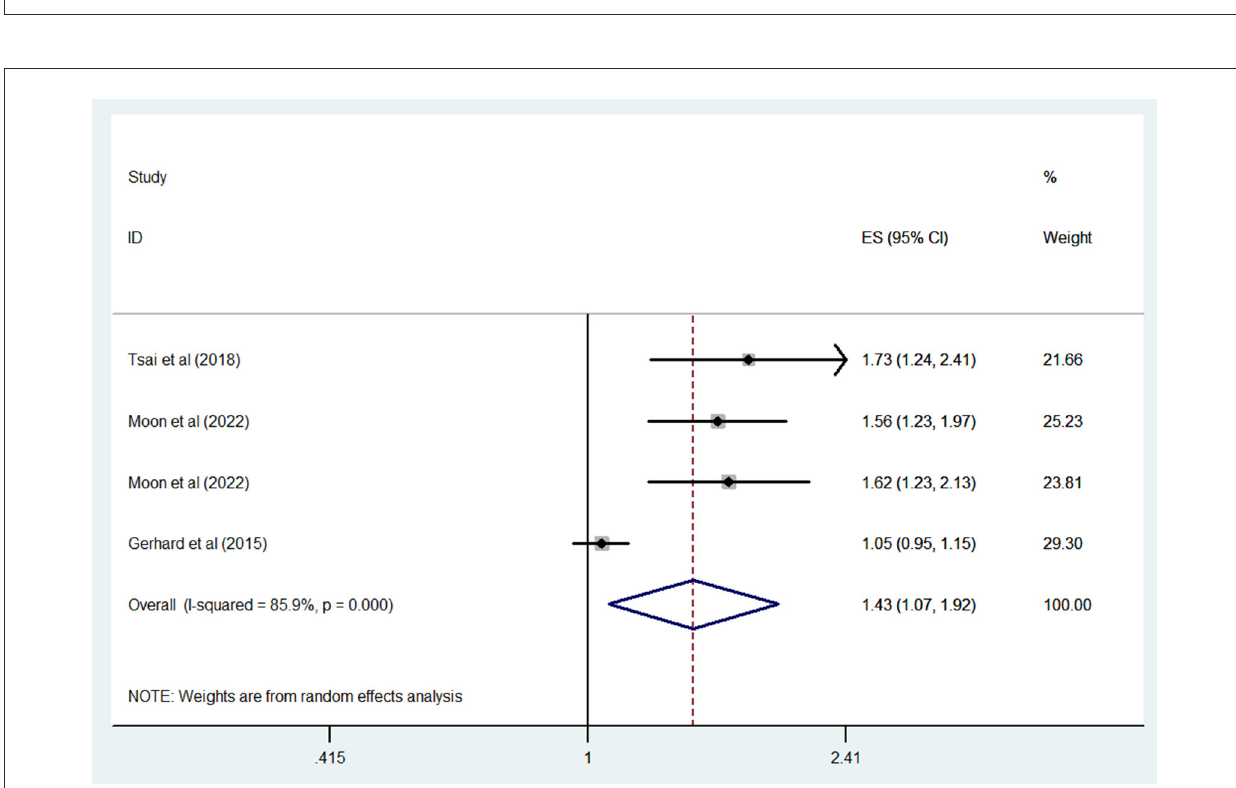
FIGURE2 Forest plot of the overall risk of dementia in relation to ASMs use among the general population.